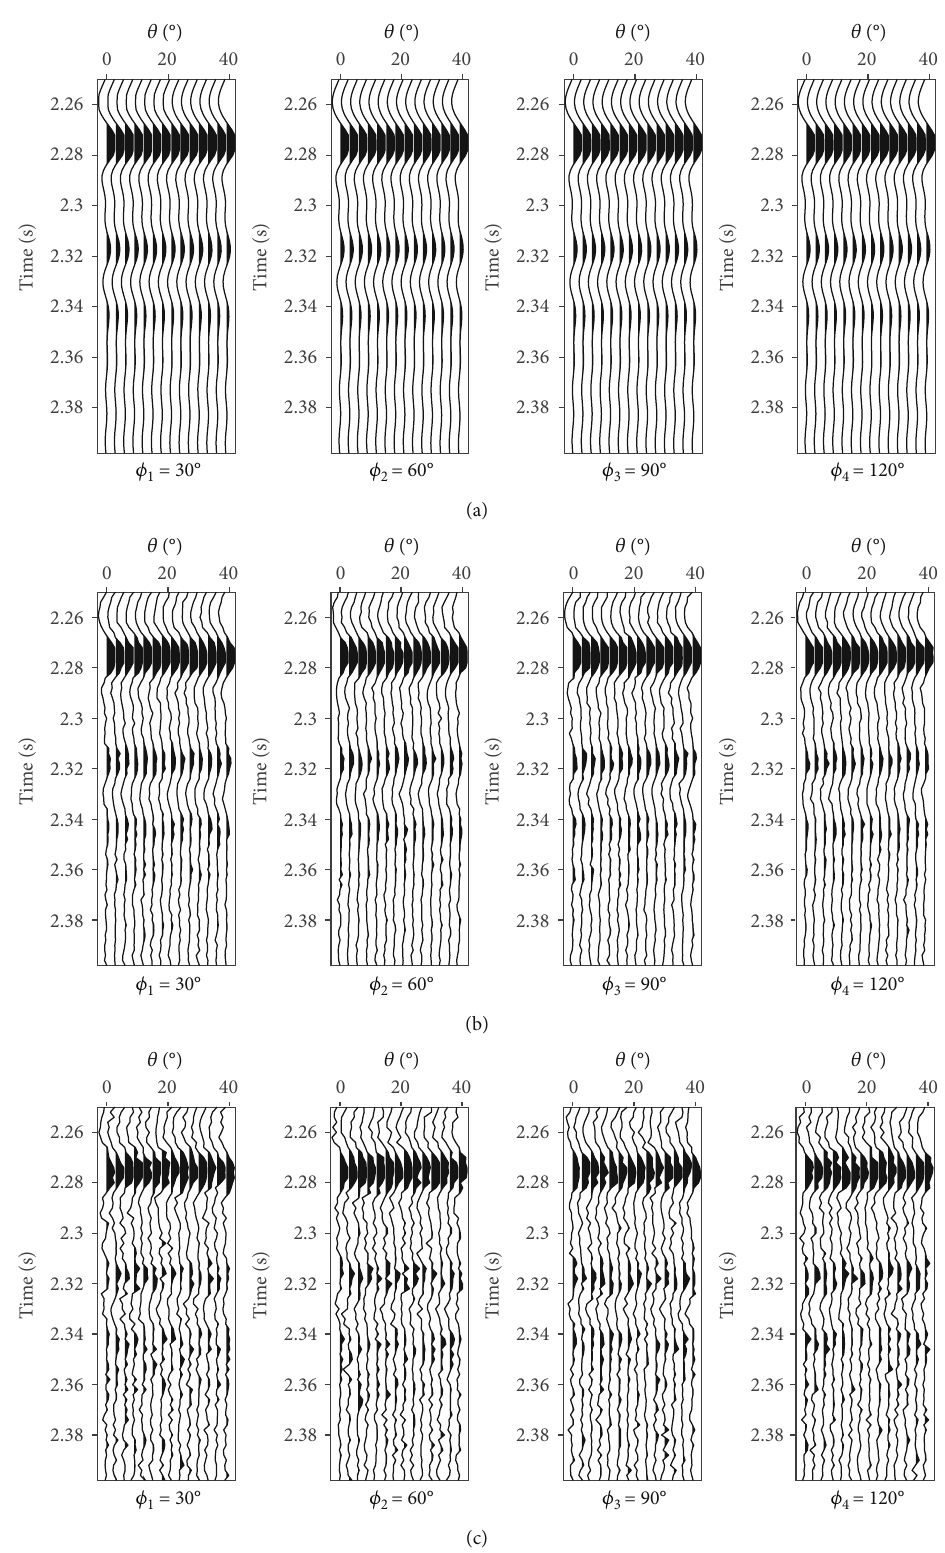
Figure 1: Synthetic azimuthal gathers with di ff erent SNRs, where (a) is noise-free, (b) is 5, and (c) is